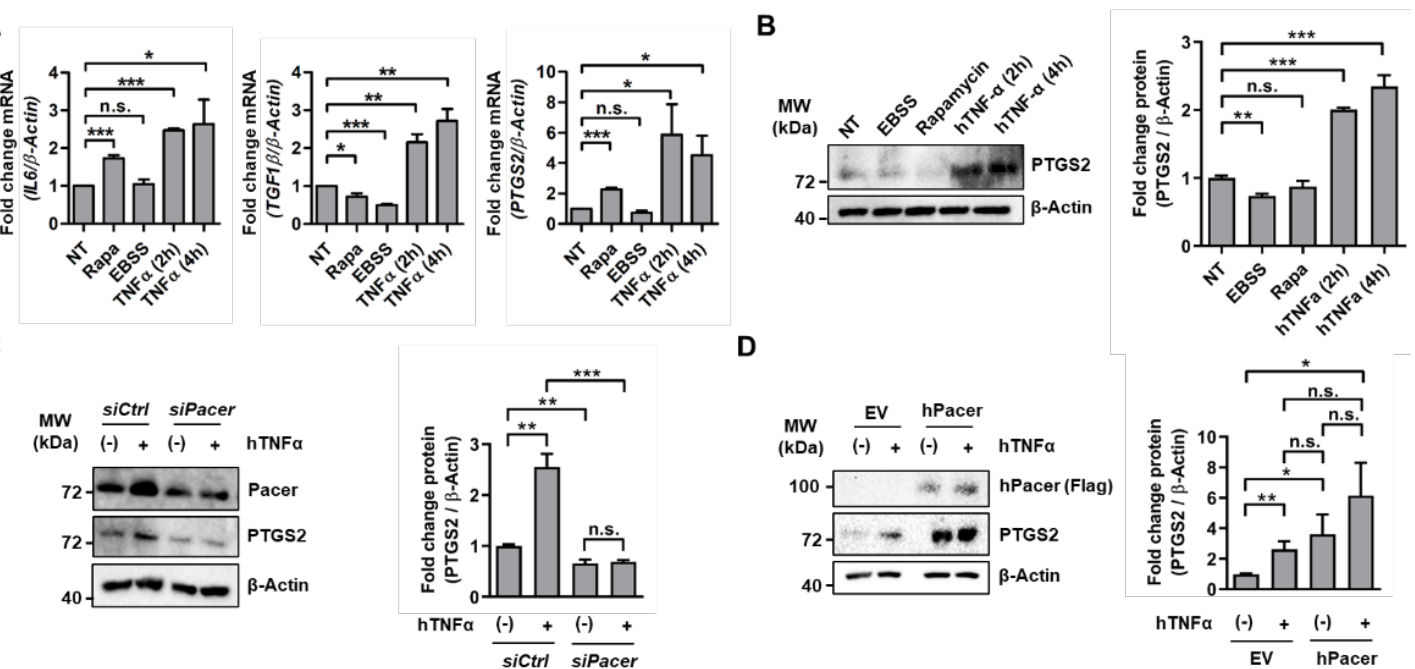
Figure 2. Pacer modulation affects PTGS2 levels in MSC. ( A , B ) MSC were treated with EBSS (4 h), Rapamycin (200 nM, 4 h) and hTNF α (10 µ g/mL, 2 h or 4 h). Non-treated control cells are designated as NT. ( A ) mRNA levels of IL6, TGF1 β and PTGS2 were determined by quantitative PCR ( n = 3). β -Actin mRNA levels were used as a reference. Student’s t -test was performed. Mean and SEM are shown: *, p ≤ 0.05; **, p ≤ 0.01; ***, p ≤ 0.001; n.s., non-significant. ( B ) PTGS2 protein levels were determined by Western blot analysis ( n = 3). β -Actin serves as a loading control. Densitometric quantifications were performed of three independent experiments. Student’s t -test was performed. Mean and SEM are shown: **, p ≤ 0.01; ***, p ≤ 0.001; n.s., non-significant. ( C ) PTGS2 protein levels under Pacer knockdown (siPacer) were determined by Western blot. Cells were treated with hTNF α (10 µ g/mL) for 4 h. As a mock control, a scrambled siRNA (siCtrl) oligo was used. Mouse Pacer and PTGS2 levels of three independent experiments were detected ( n = 3). β -Actin serves as a loading control. Densitometric quantification of PTGS2 levels normalized to β -Actin levels is shown ( n = 3). Student’s t -test was performed. Mean and SEM are shown: **, p ≤ 0.01; and ***, p ≤ 0.001; n.s., non-significant. ( D ) PTGS2 protein levels were determined by Western blot under human Pacer (hPacer) overexpression. Cells were treated with hTNF α (10 µ g/mL) for 4 h. As a mock control, an empty vector (EV) construct was used. hPacer and PTGS2 were detected in five independent experiments ( n = 5). β -Actin serves as a loading control. Densitometric quantifications of PTGS2 normalized to β -Actin levels is shown ( n = 5). Statistical analyses were performed using Student’s t -test. Mean and SEM are shown: **, p ≤ 0.01; and ***, p ≤ 0.001; n.s.,